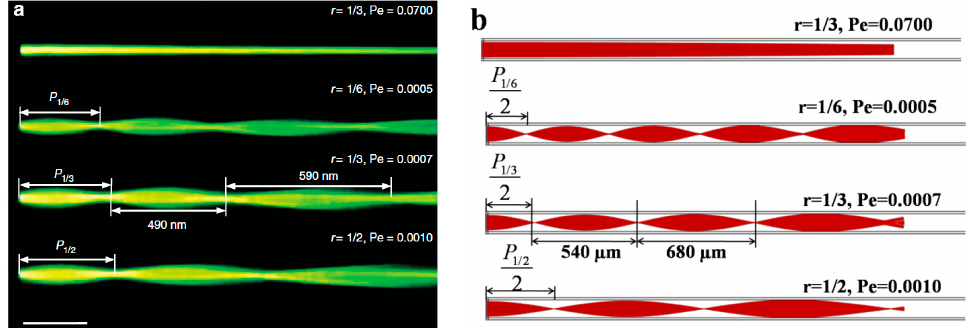
Figure 2. ( a ) Observed light propagation under different flow conditions [23]. At a high flow rate